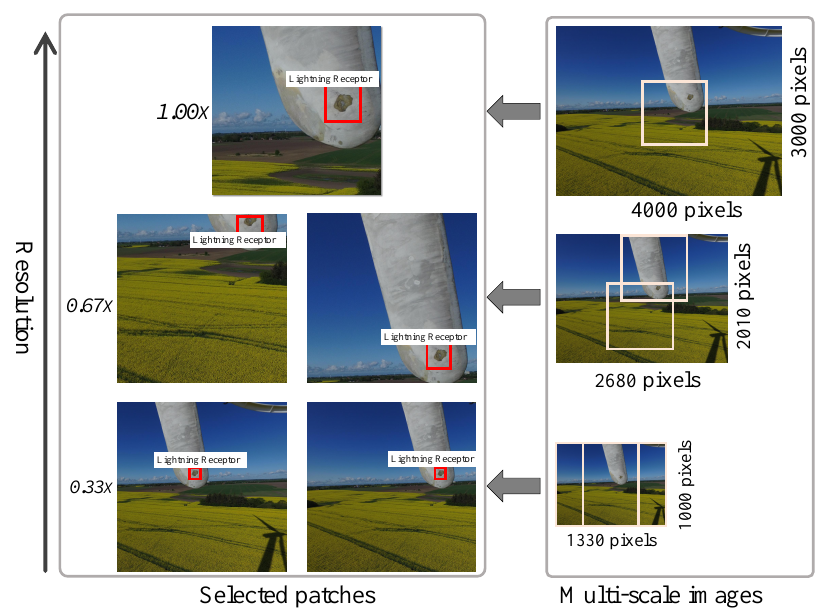
Figure 4. Proposed multi-scale pyramid and patching scheme for image